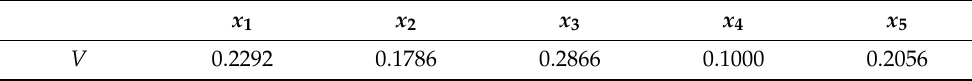
Table 3. Ranking vector of the possibility degree